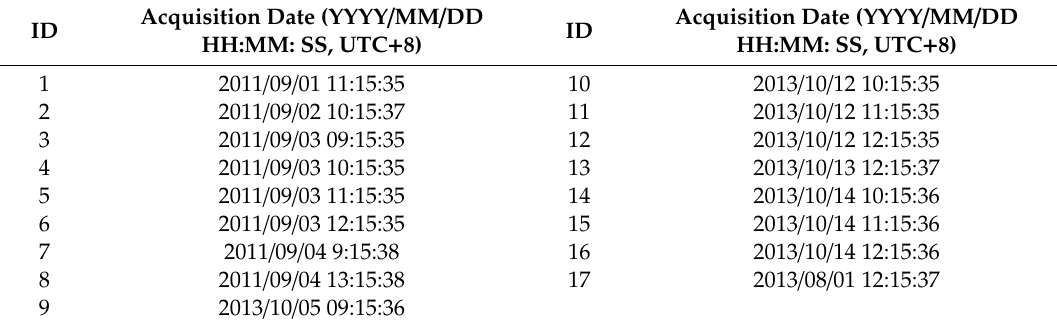
Table 1. Geostationary Ocean Color Imager (GOCI) images used in the